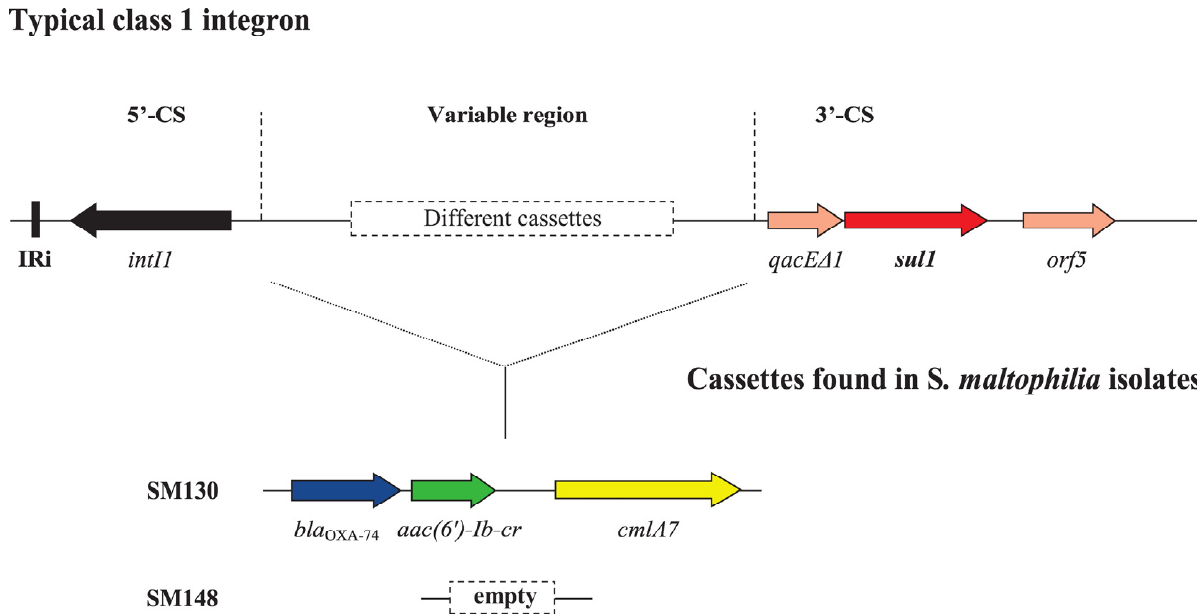
Figure 3. Linear map of a typical class 1 integron. IRi marks an inverted repeat that flanks the intI1 gene encoding class 1 integrase. The dotted rectangle represents a cassette array with a variable composition. The conserved sequence in the 3 ′ end of the integron includes qacE Δ 1 (quaternary ammonium compound efflux SMR transporter), sul1 (dihydropteroate synthase type-1), and orf5 (unknown function). Below are the two gene cassettes found in isolates SM130 and SM148. The SM130 gene cassette contains the following genes: bla OXA-74 (OXA-10 family class D b-lactamase OXA-74), aac(6 ′ )-Ib-cr (fluoroquinolone-acetylating aminoglycoside acetyltransferase), and cmlA7 (chloram- phenicol acetyltransferase). OXA, oxacillinase; SMR, small multidrug resistance.